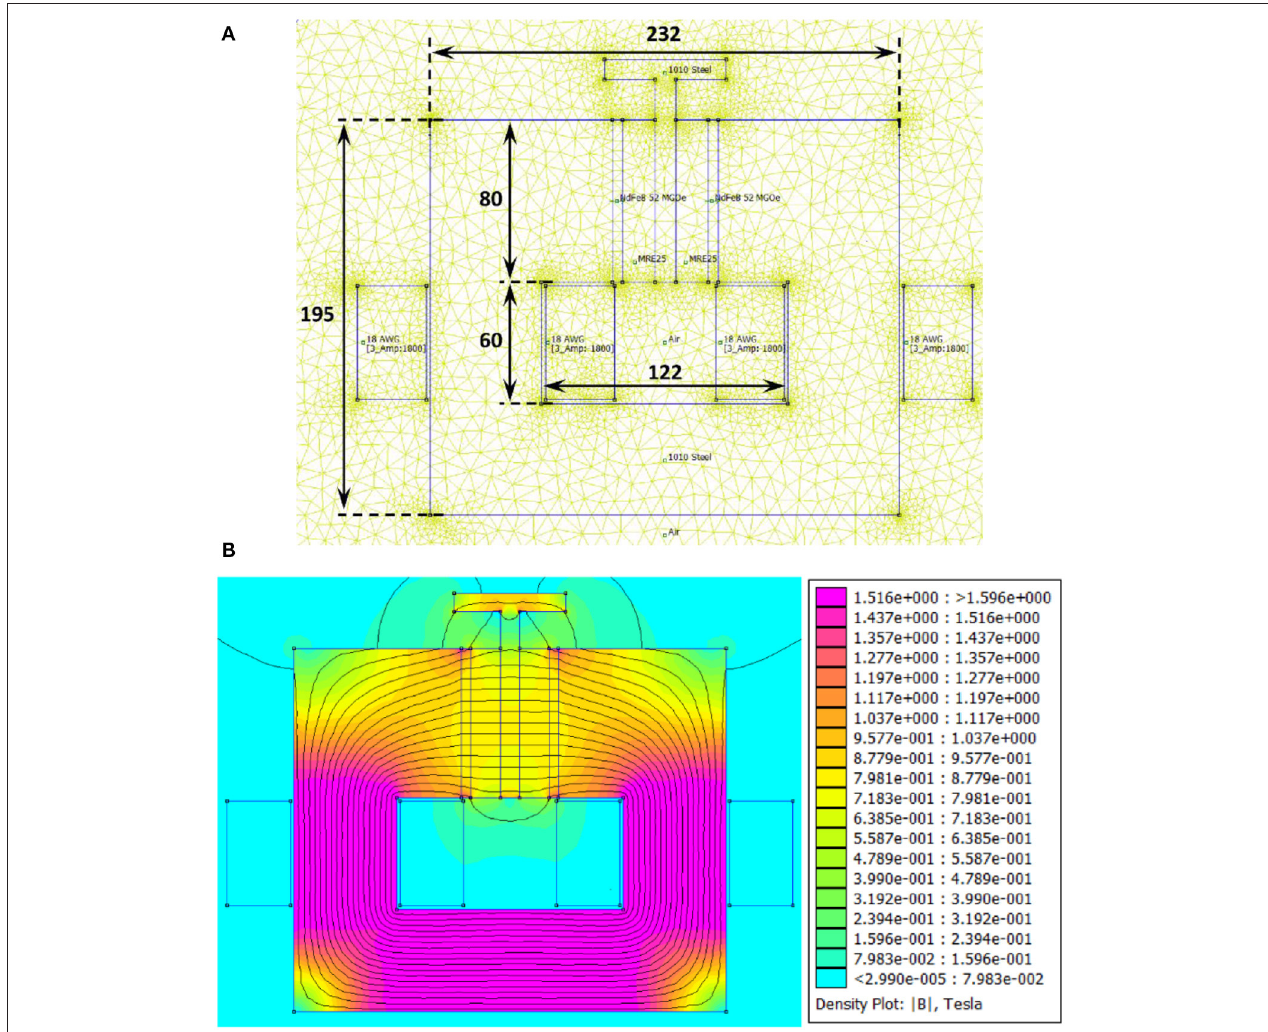
FIGURE 7 | FE magnetic analysis of the MRE-based isolator; (A) FE model and (B) results for 3A current input to the coils.